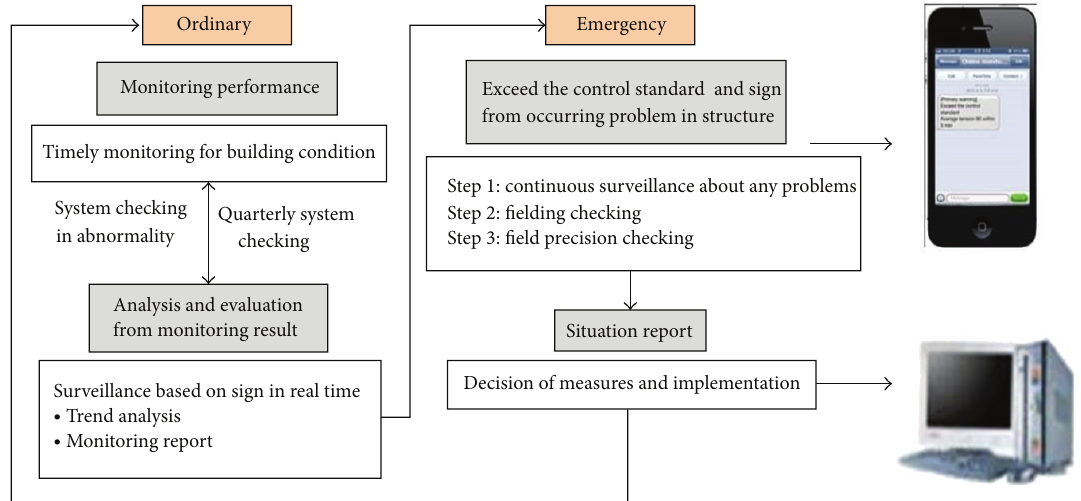
Figure 7: Warming system (SMS